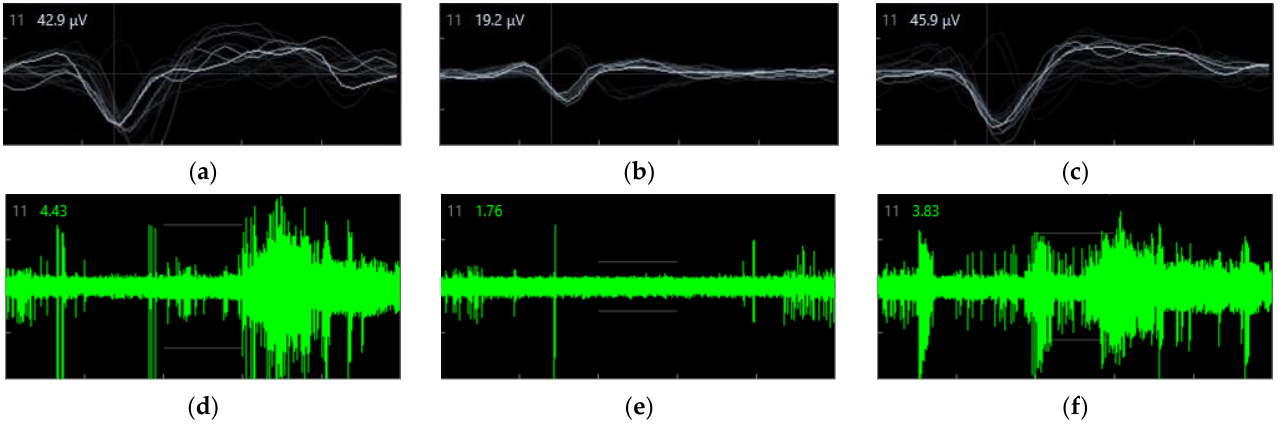
Figure 6. Spike amplitude recorded by the same electrode in three crucial different timepoints: in all three panels, the typical waveform of the EAP is evident. EAP waveform consists of three main distinct phases: (i) a brief, positive deflection; (ii) a larger negative peak; and (iii) a positive peak of longer duration. The first positive peak of the waveform is due to the positive capacitive current; the second, larger negative peak is the result of Na + influx eliciting the internal action potential; and the last, longer positive peak mainly corresponds to the K + efflux responsible for the cell repolarization. ( a ) baseline ( b ) after 15 min of treatment with LEV ( c ) at 24 h after medium replacement (on left upper angles in a, b, and c panels, light-grey numbers represent the electrode number, while white numbers correspond to the last EAP amplitude). Continuous waveform plot of the same electrode showing spiking activity at baseline ( d ), 15 min of treatment with 1 mM LEV ( e ), and at 24 h after medium replacement ( f ) (on left upper angles in d, e, and f panels, light-grey numbers represent the electrode number, and the green ones correspond the basal noise).